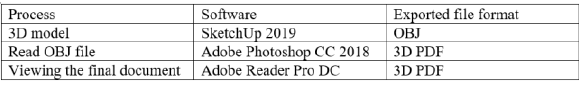
Table 1. The process involved in 3D PDF Generation